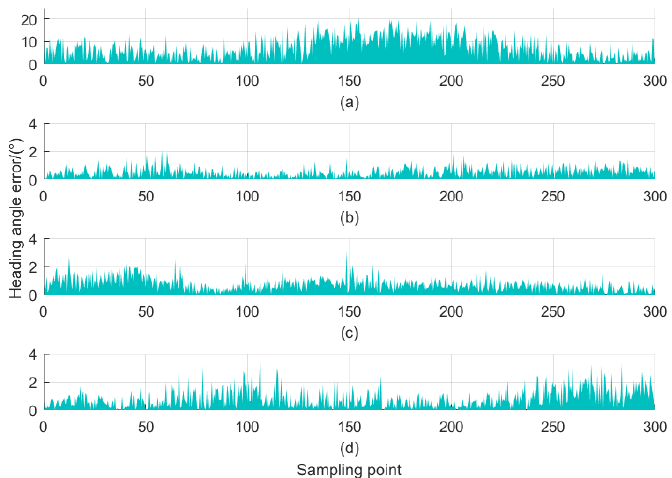
Figure 9. The estimated heading angle error before and after correction by the proposed two-step estimator. ( a ) before correction; ( b ) the interference source radius is 90 cm; ( c ) the interference source radius is 70 cm; ( d ) the interference source radius is 50 cm.